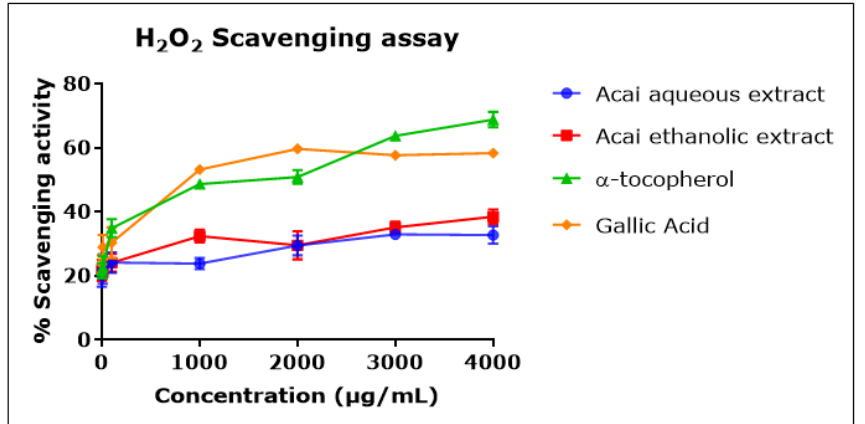
Figure 4. H 2 O 2 scavenging activity of acai aqueous and ethanolic extracts. Acai antioxidant